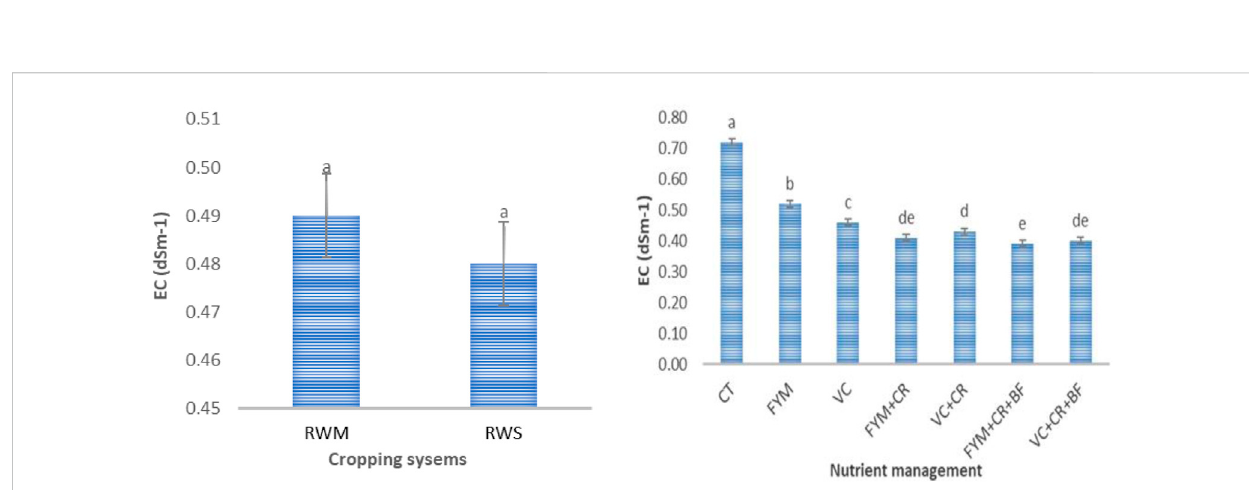
FIGURE 3 Long-term effect of cropping systems and organic nutrient management on soil EC. EC: electrical conductivity; RWM: rice-wheat-mung bean; RWS: rice-wheat-sesbania; CT: control; FYM: farm yard manure; VC: vermicompost; CR: crop residue(s); and BF: biofertilizer(s). Statistical method: analysis of variance for strip-plot design in SAS 9.3 software; n = 42. Values with a different capital letter indicate a signi fi cant difference among the different treatments at p < 0.05 by the LSD test. Bars represent means ±